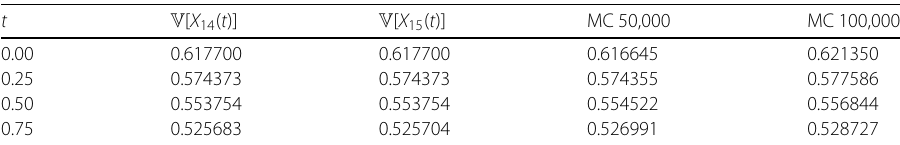
Table 15 Approximation of the variance of the solution stochastic process. Example 4.4, assuming dependent initial